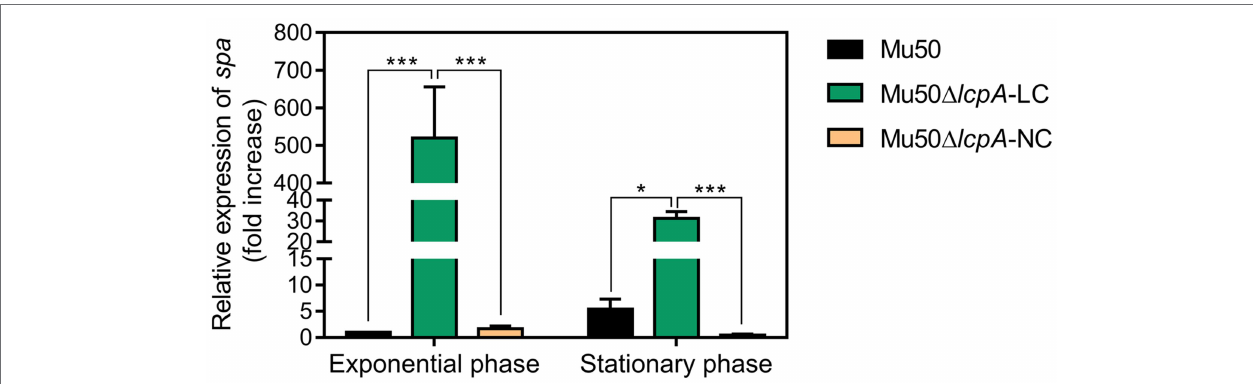
FIGURE 4 | qRT-PCR analysis for expression of spa in Mu50 isogenic strains grown at the exponential phase and the stationary phase. Genes were normalized with the expression level of gyrB . Error bars correspond to SEM, five independent experiments. One-way ANOVA with LSD test for multiple comparisons, * p < 0.05, ** p < 0.01, *** p <